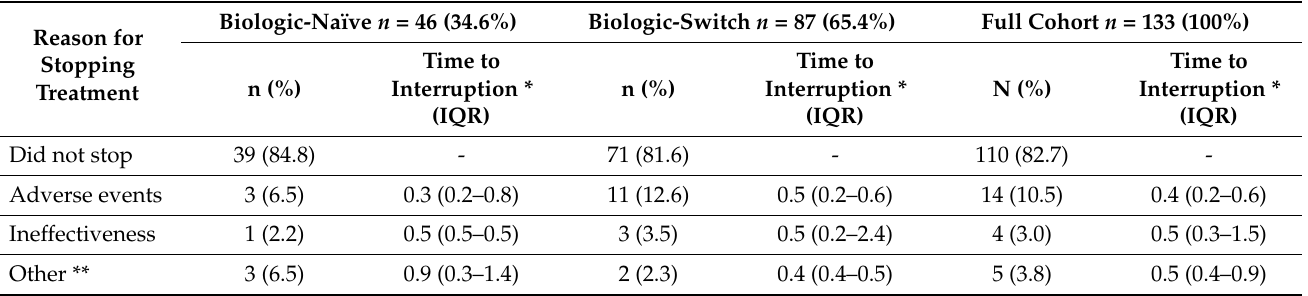
Table 7. Proportion of patients that stopped treatment in the biologic-naïve and biologic-switch cohorts of the effectiveness